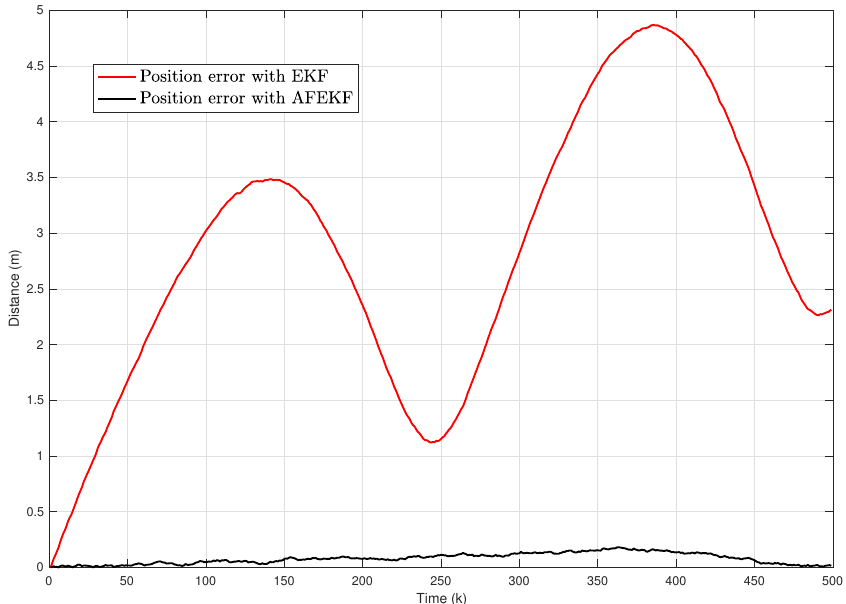
Figure 4. Robot’s position errors under constant